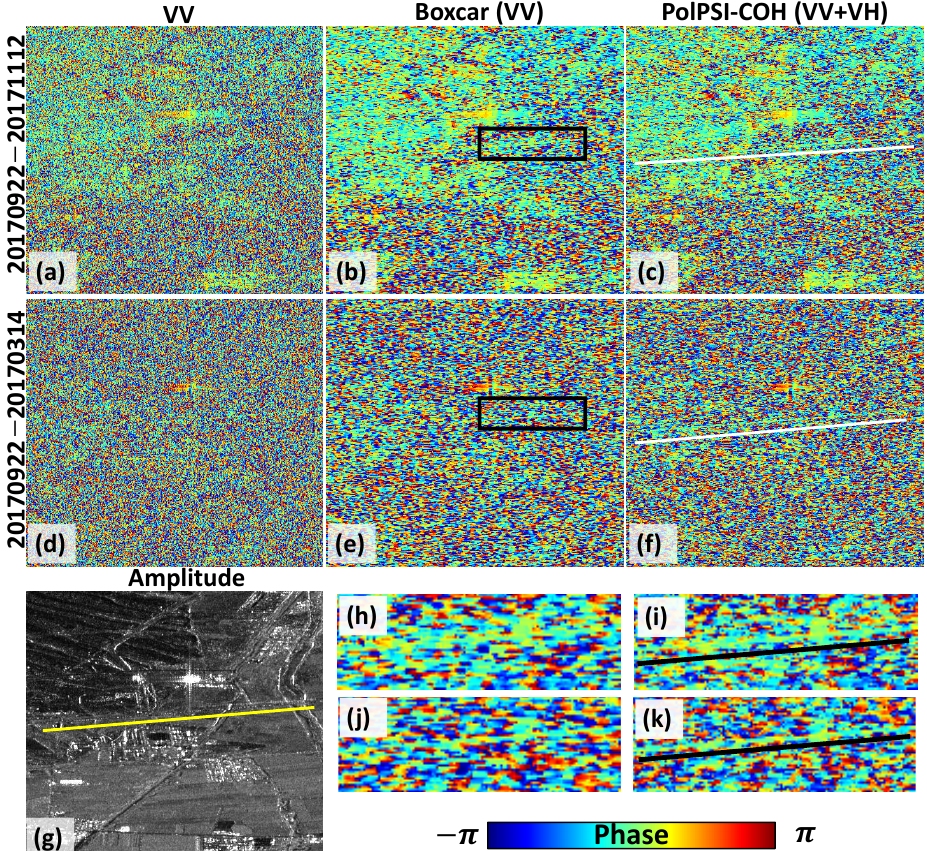
Figure 10. Interferograms of VV channel ( a , d ), Boxcar ( b , e , h , j ), and PolPSI-COH ( c , f , i , k ) over the a subsection of Fukang area, respectively. The number on the left of the first and second row indicates the corresponding interferograms’ temporal baseline. ( g ) is the corresponding SAR amplitude image, ( h , j ) shows the close-up area (limited by the black rectangle in ( b , e )) in ( b , e ), respectively. The PolPSI-COH counterparts over the same close-up area are shown in ( i , k ). All the sub-figures are in SAR